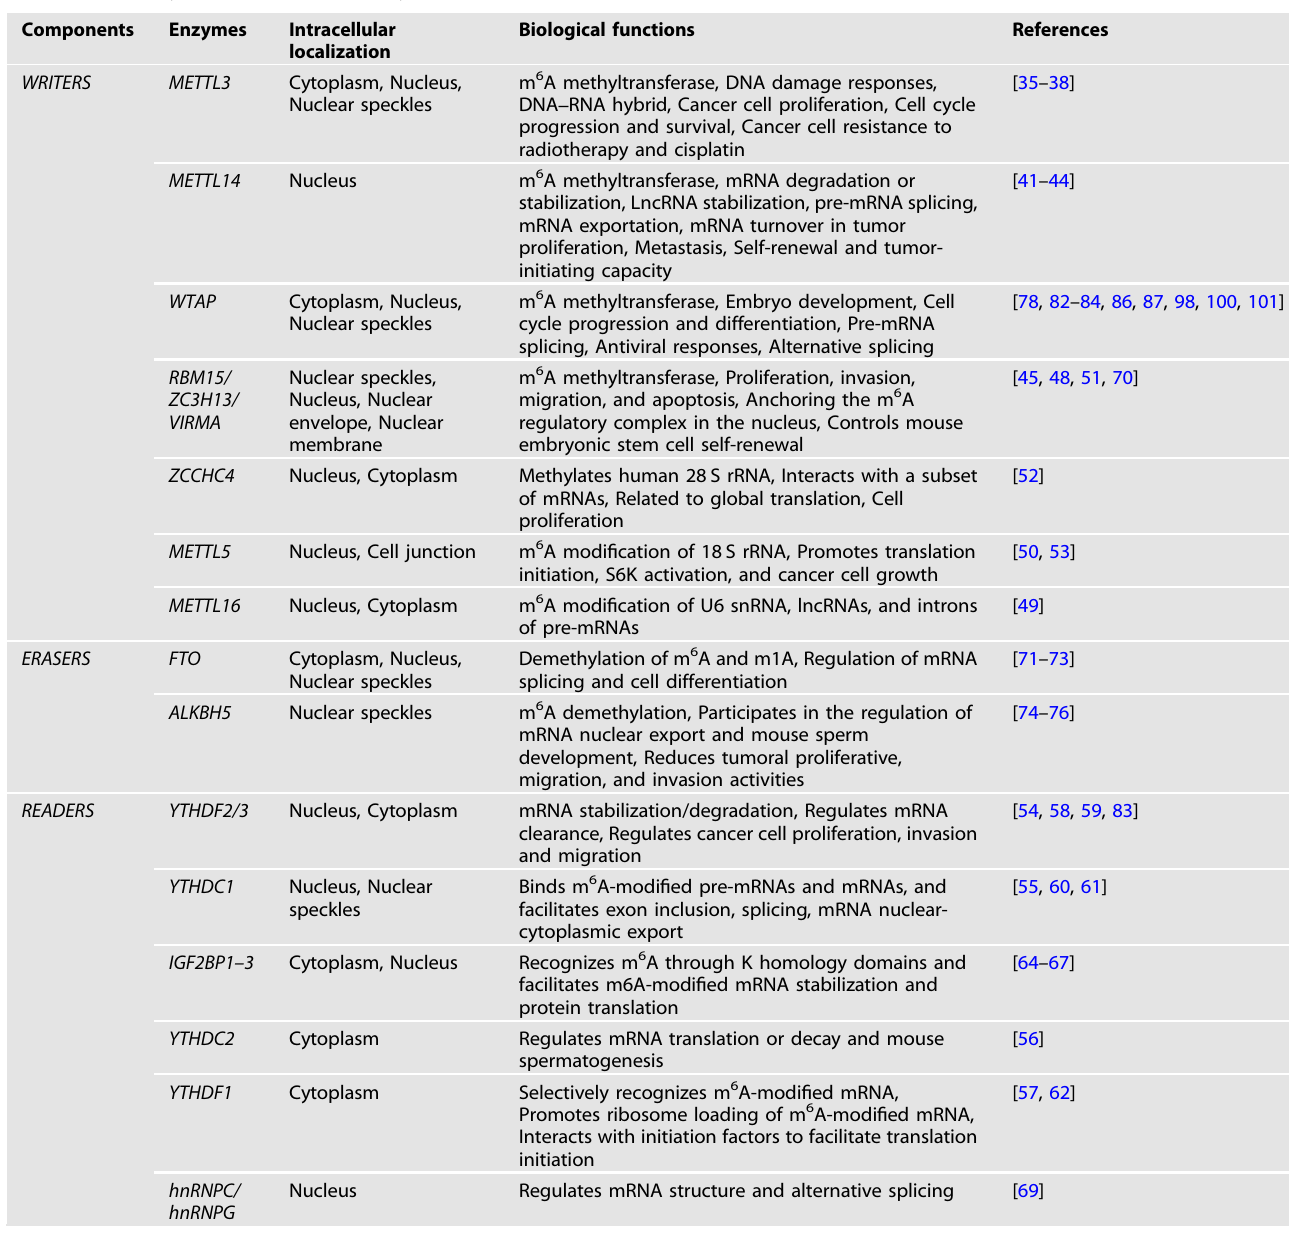
Table 1. Summary of m 6 A modi fi cation enzymes.